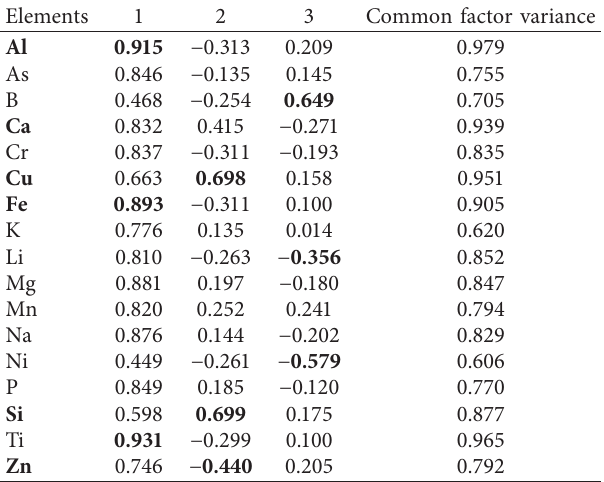
Figure 3: Accumulation content of elements from the different areas and tissues (note: the same as the Figure 2). Table 6: Eigenvalue and variance contribution rate of principal Table 7: Factor load matrix of principal component component analysis.